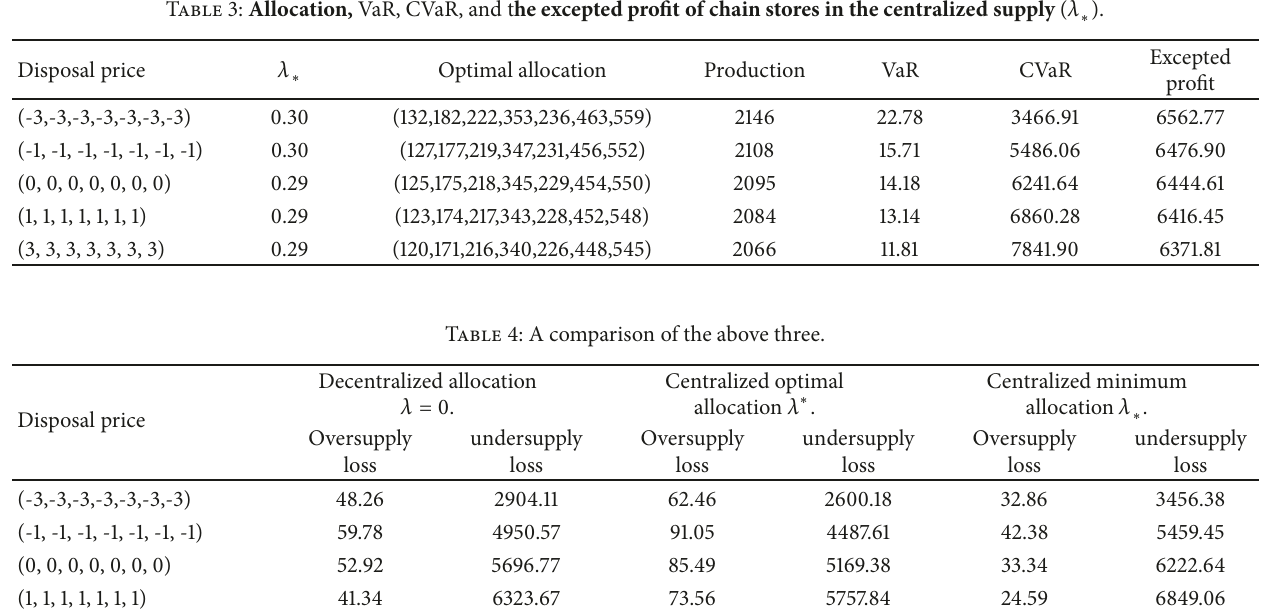
Table 3: Allocation, VaR, CVaR, and t he excepted profit of chain stores in the centralized supply ( 𝜆 ∗ ). Disposal price